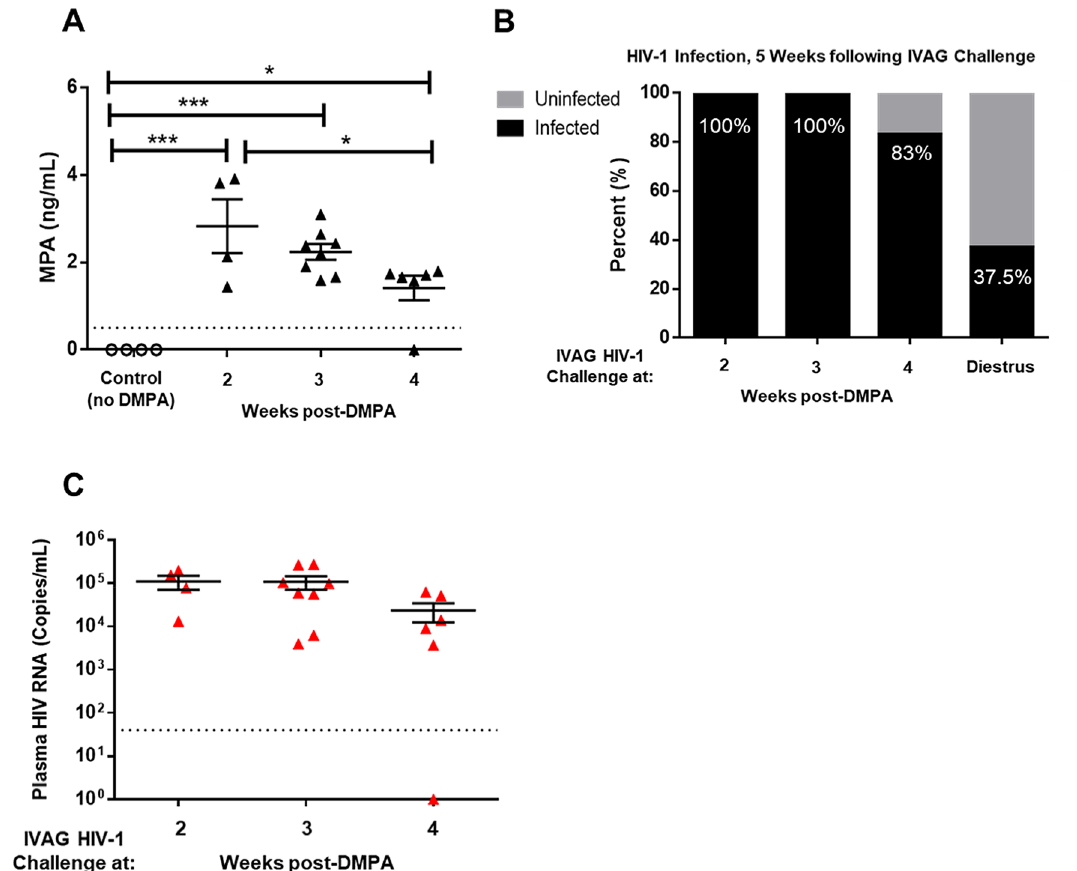
Figure 3. DMPA extends the window of susceptibility to HIV-1 infection in humanized mice. Hu-mice were treated with 2 mg subcutaneous DMPA and received IVAG challenge with HIV-1 at 2, 3, or 4 weeks post- DMPA (N = 18) to determine if the window of HIV-1 susceptibility was extended in DMPA-treated Hu-mice than cycling Hu-mice which were only susceptible to HIV-1 during diestrus (~ 50% of the estrous cycle). ( A ) To confirm that Hu-mice were under the influence of DMPA, MPA, the active ingredient in DMPA, was quantified in the serum. MPA decreased between 2 and 4 weeks post-DMPA, and the amount of MPA was significantly greater in DMPA-treated Hu-mice than controls (N = 4) that had not received DMPA (2.8 ± 0.6 at 2 weeks, 1.4 ± 0.3 at 4 weeks, and 0.0 ± 0.0 ng/mL in controls; P < 0.0001, one-way ANOVA). ( B ) Hu-mice were challenged IVAG with HIV-1 at 2, 3, and 4 weeks post-DMPA according to Supplemental Fig. 1. At 2 (N = 4) and 3 (N = 8) weeks post-DMPA 100% of the Hu-mice were susceptible to HIV-1 infection, while at 4 weeks post-DMPA (N = 6) 83% of Hu-mice were susceptible. In comparison, only 37.5% of Hu-mice challenged during diestrus were susceptible to HIV-1 infection (Fig. 2). ( C ) Plasma viral titres were compared between groups, at 5 weeks post-challenge, and the titres were not significantly different. Hu-mice challenged 2, 3, or 4 weeks post-DMPA had equivalent HIV-1 titres at 5 weeks post-infection (1.1 × 10 5 ± 4.0 × 10 4 , 1.1 × 10 5 ± 3.8 × 10 4 , 2.8 × 10 4 ± 1.2 × 10 4 HIV-1 RNA copies/mL respectively; P = 0.1497 one-way ANOVA). * P ≤ 0.05. *** P ≤ 0.001. Data in A and C is presented as mean ± SEM, data in B is presented as proportions (percent infected). DMPA Depot-medroxyprogesterone acetate, IVAG intravaginal, MPA medroxyprogesterone acetate (active ingredient of